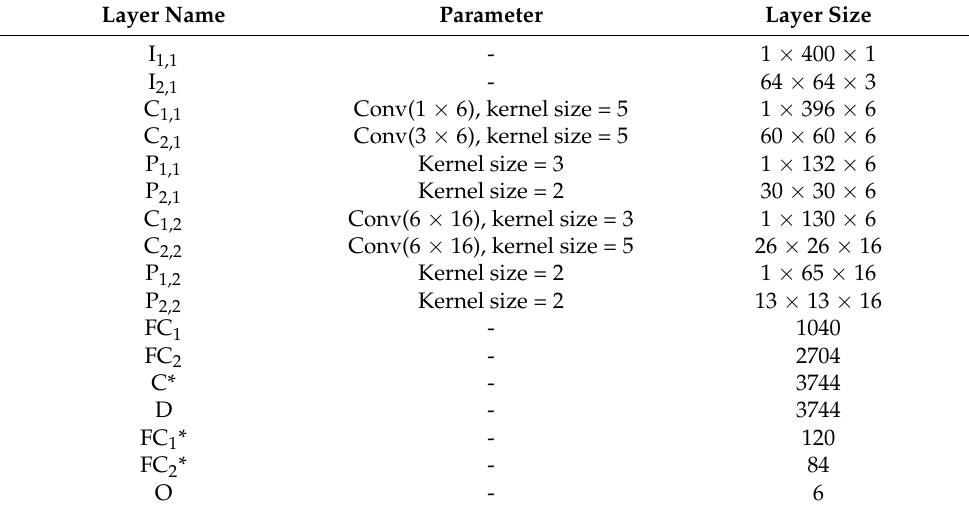
Table 5. TC-CNN parameters for defect classification. Referring to other TC-CNN models, * is to distinguish layers with the same name that have appeared